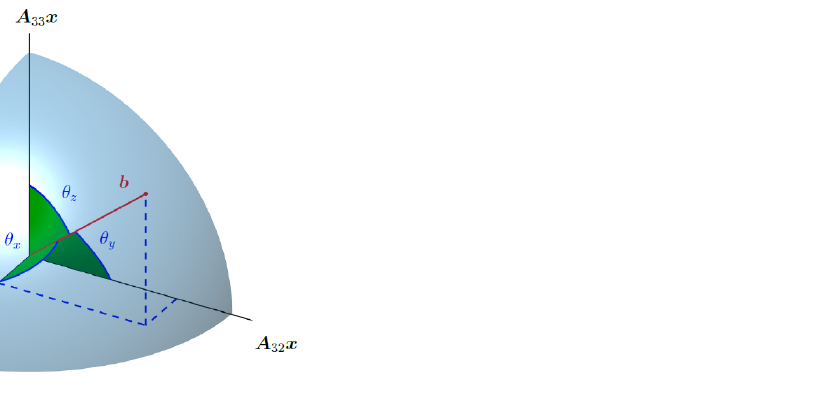
Figure 3. Measurement b is estimated to lie in a 3-dimensional subspace spanned by the estimates for the field projections in the x , y and z directions, i.e., A 31 x , A 32 x and A 33 x . We, thus, need to find a point on a sphere of radius (cid:107) b (cid:107)